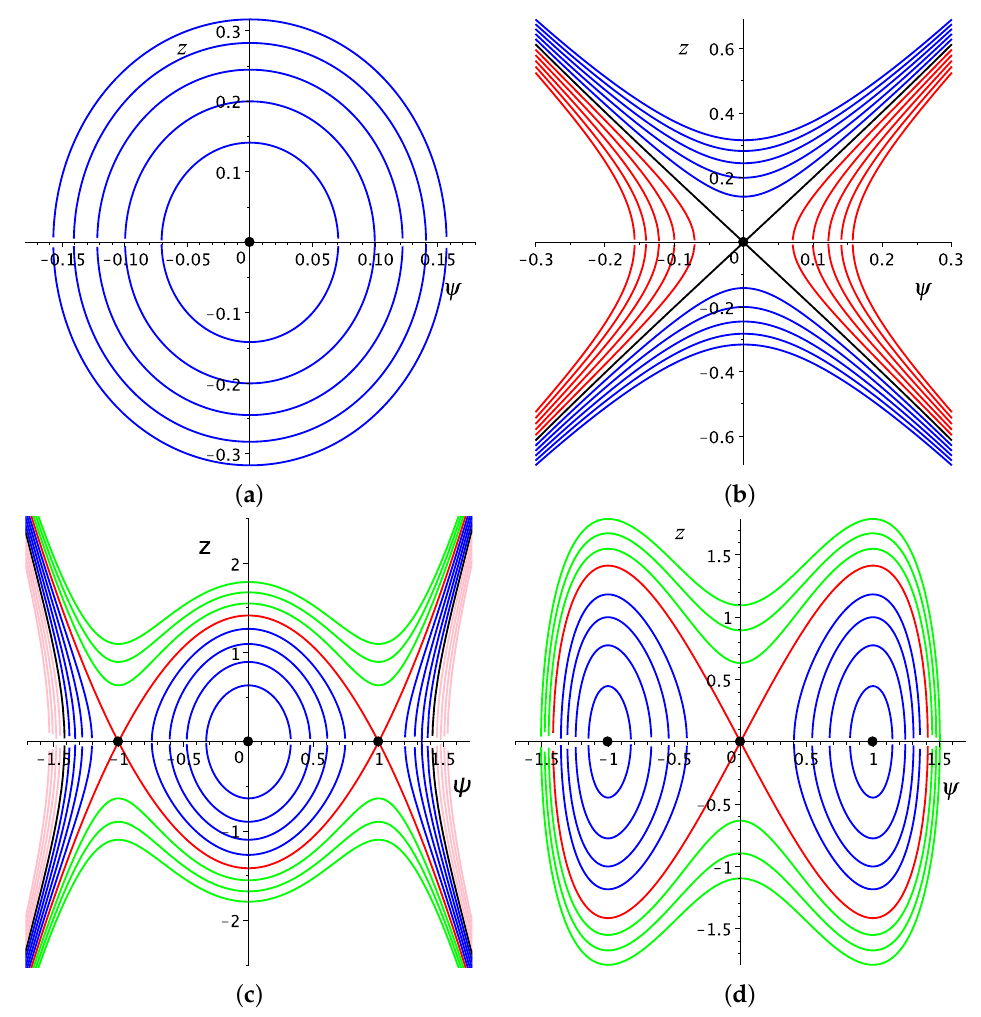
Figure 2. Phase portrait for the Hamiltonian system (14) in the phase plane ( ψ , z ) for different values ρ 1 and ρ 2 , with the black solid circles indicating the equilibrium points. ( a ) ρ 1 = 2, ρ 2 = 1; ( b ) ρ 1 = − 2, ρ 2 = − 1; ( c ) ρ 1 = 2, ρ 2 = − 1; ( d ) ρ 1 = − 2, ρ 2 =